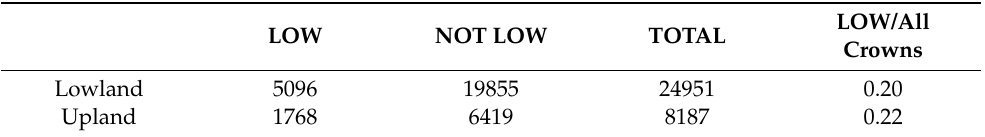
Figure 5. Graph of the proportion of LOW tree crowns (ITCs) in the eight stands with standard error. Stands that are not significantly different (two tailed Z-score tests of a proportion, p > 0.01) have the same italicized letter ( a – e ). For example, U-NM and L-Rx, are not significantly different; U-HP, L-2Rx and L-HE are not significantly different. Stand treatment descriptions are as follows: U-NM is upland, no management; L-Rx is lowland prescribed fire (2008); L-HP is lowland, harvest in 2016, retention of trees in groups; L-NM is lowland, no management; U-HP is upland, harvest in 2016, retention of trees in groups; L-2Rx is lowland, prescribed fire in 2006 and 2013; L-HE is lowland, harvest even spacing; and L-HE-2Rx is lowland, harvest even spacing, prescribed fire in 2006 and 2013. Table 7. Proportion of LOW RF-modeled individual tree crowns (ITCs) in upland and lowland sites. The proportion of LOW crowns was significantly different (two tailed Z-score tests of a proportion, p = 0.023) for the two site